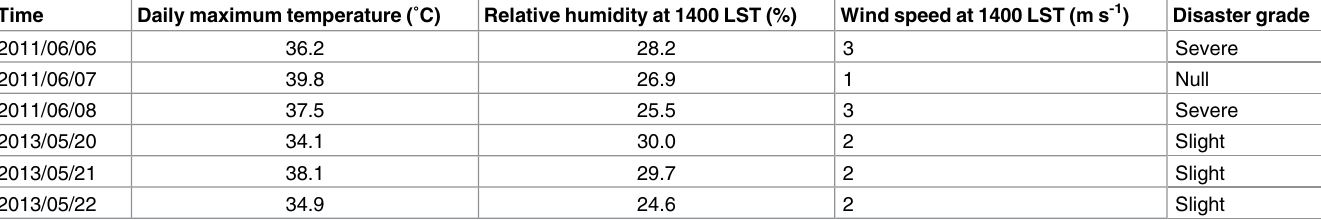
Table 1. DHW occurrences at Wugong in June, 2011 and May, 2013, with factor values and disaster grade. Time Daily maximum temperature